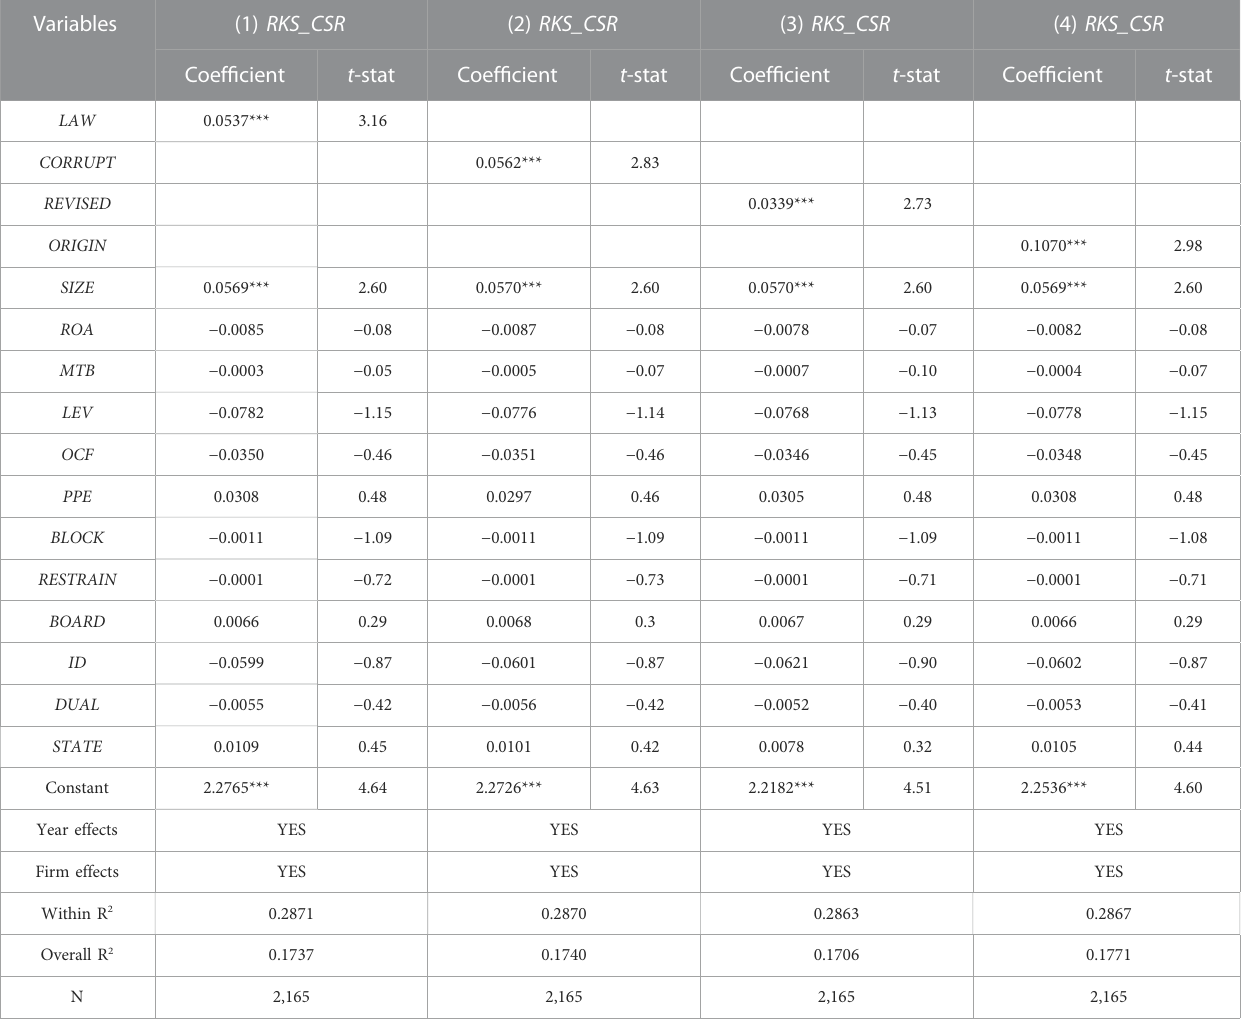
TABLE 7 CEO ’ s foreign experience and CSR (Effects of country or region-level institutional factors).